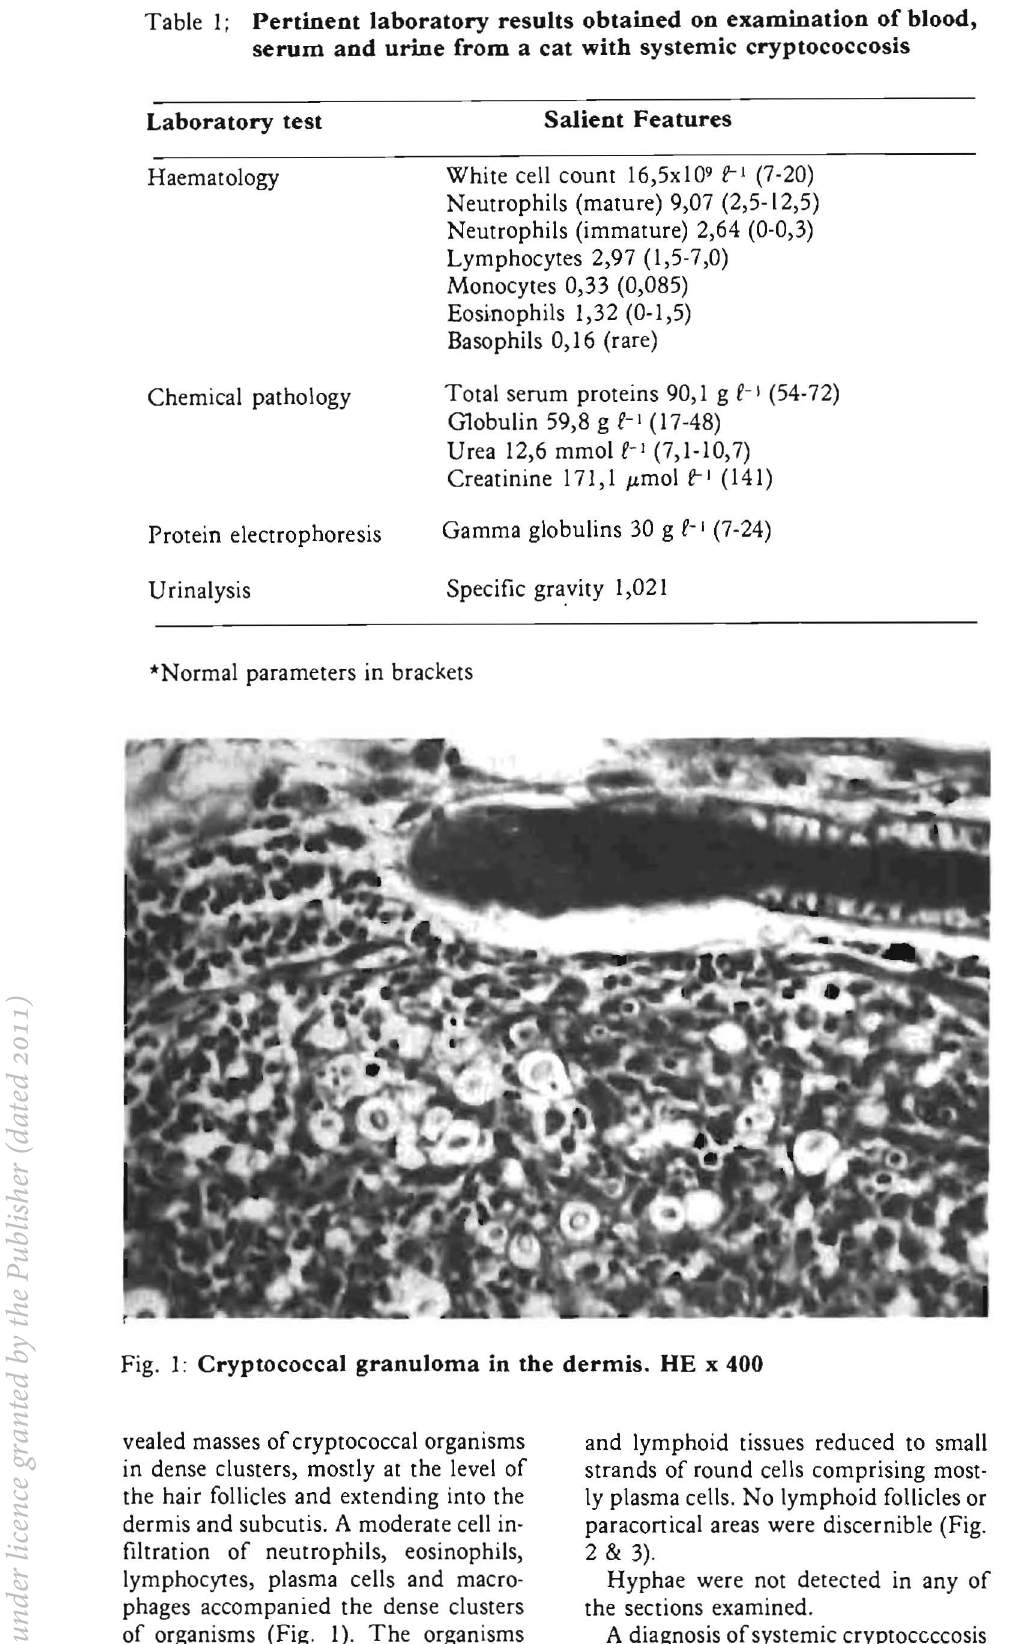
Fig. 1: Cryptococcal granuloma in the dermis. HE x 400 vealed masses of cryptococcal organisms in dense clusters, mostly at the level of the hair follicles and extending into the dermis and subcutis. A moderate cell in filtration of neutrophils, eosinophils, lymphocytes, plasma cells and macro phages accompanied the dense clusters of organisms (Fig. 1). The organisms showed typical morphological features of Cryptococcus sp., particularly when stained with periodic acid schiff (PAS), Gomori's methenamine silver (GMS) and a superimposed GMS-HE combina tion.